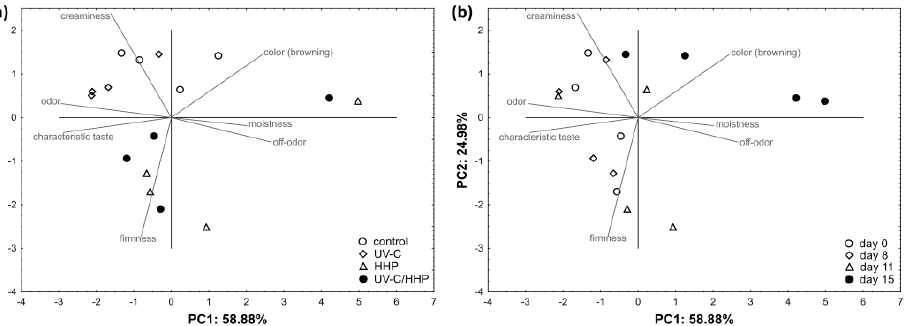
Figure 7. Distribution of boiled, fresh-cut potatoes in two-dimensional coordinate system defined by the first two principal components (PC1 and PC2) in relation to the ( a ) treatment and ( b ) storage time.